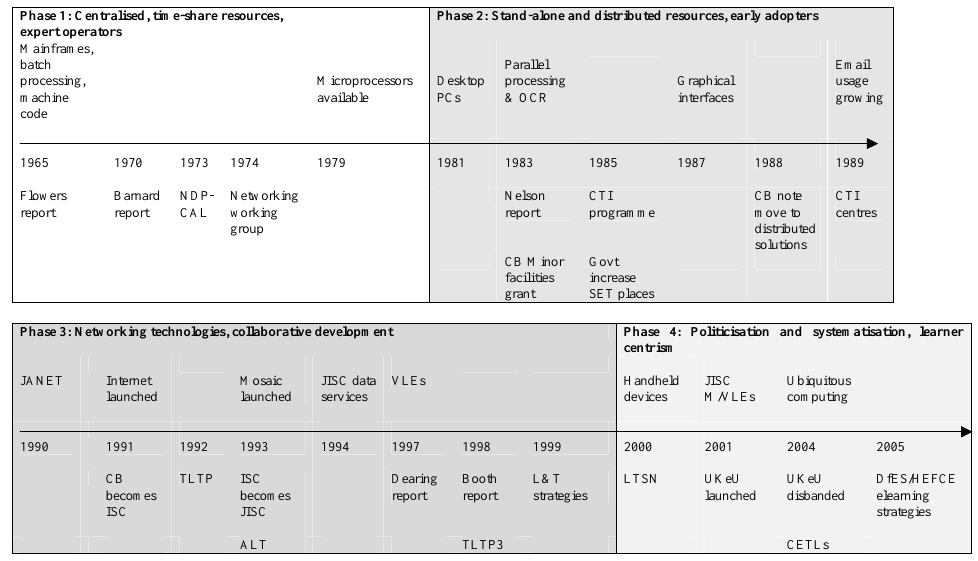
Figure 1. Timeline of technology and policy development in UK higher